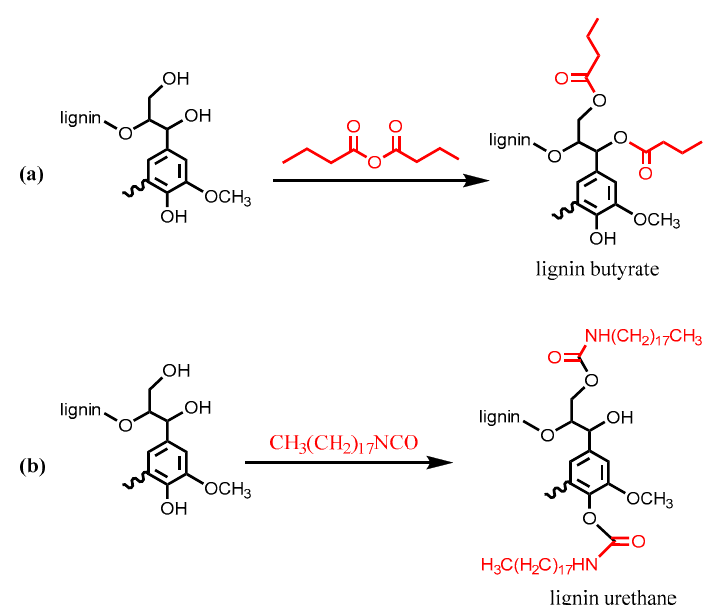
Figure 2. Synthesis of lignin butyrate ( a ) and lignin urethane ( b ). Adapted from [22] with permission from Elsevier © 2020.